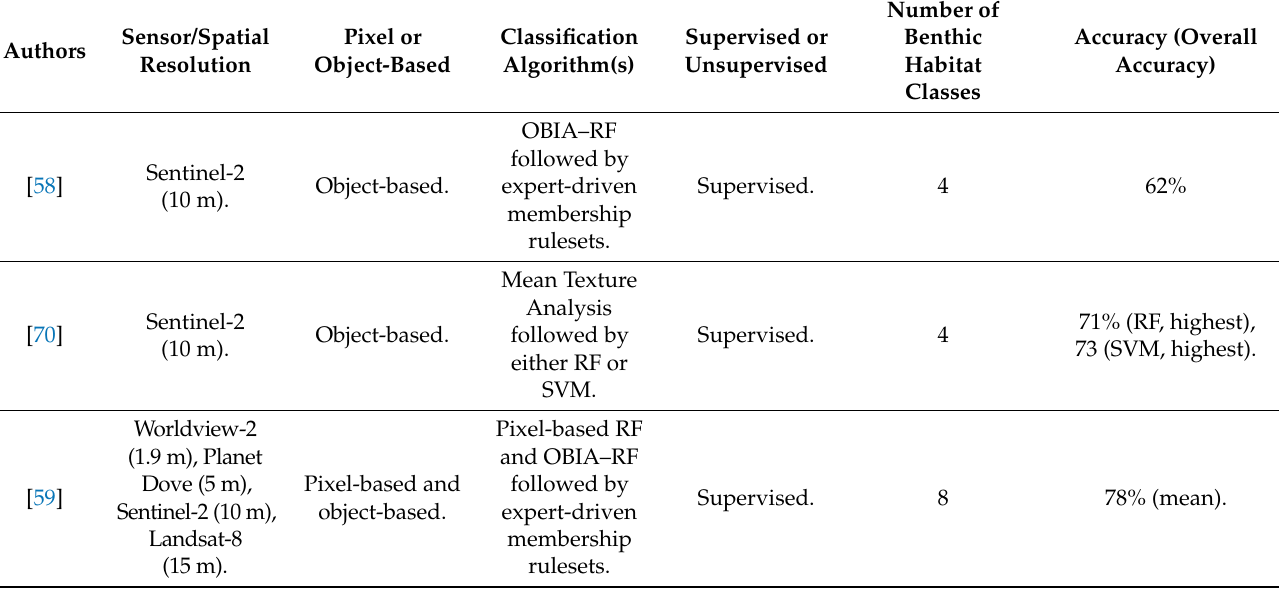
Figure 5. General conceptualisation of an SVM. Table 2. Object-based coral reef benthic mapping publications.